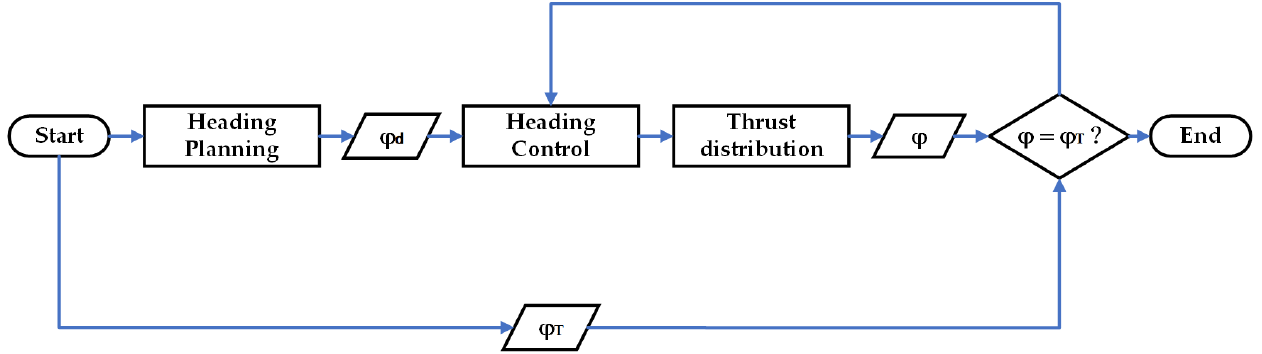
Figure 8. Flow chart of heading planning control.